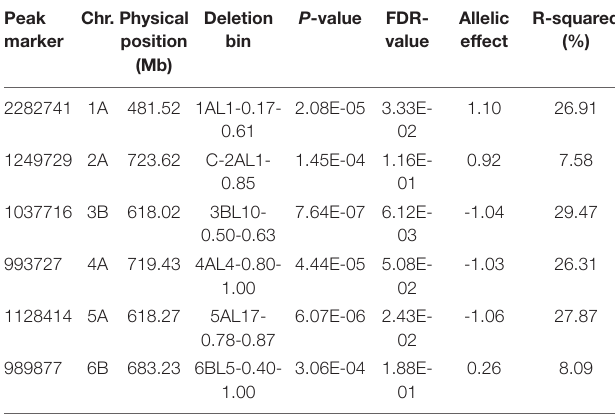
TABLE 1 | Summary of significant markers detected in association mapping of Karnal bunt resistance in common